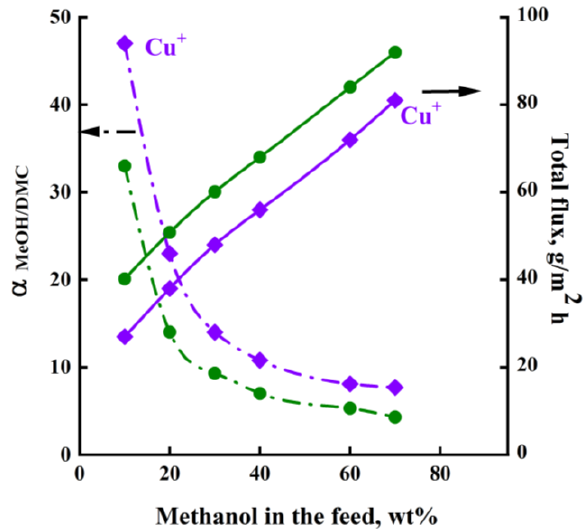
Figure 9. Dependence of separation factor ( α MeOH/DMC ) and total flux on methanol concentration in